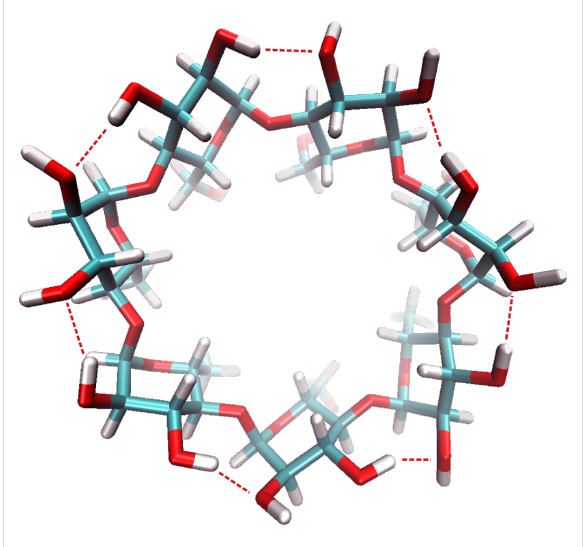
Figure 3: Structural drawing of β -CD [43], according to structural data (CSD-ID BUVSEQ03) from Zabel et al. [38], generated by VMD 1.8.4 showing the intramolecular hydrogen bonds between OH-3 and